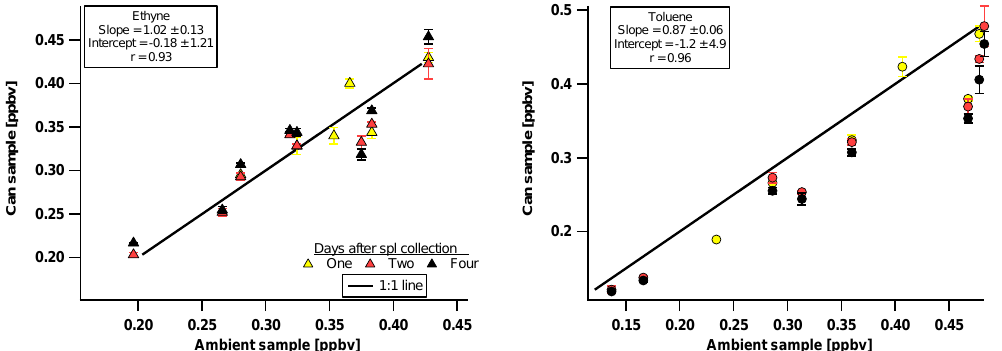
Figure 8. Canister samples versus in situ ambient samples collected in Boulder, CO, using sample canisters humidified to 12 torr water vapor during the cleaning process. Error bars indicate standard deviation of replicate canister